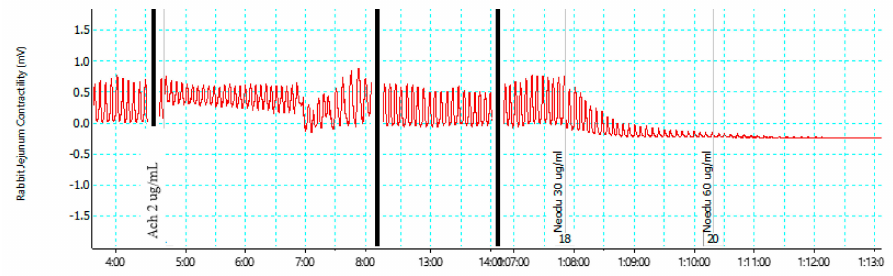
Figure 2. Effect of compound 2 on isolated rabbit jejunum.